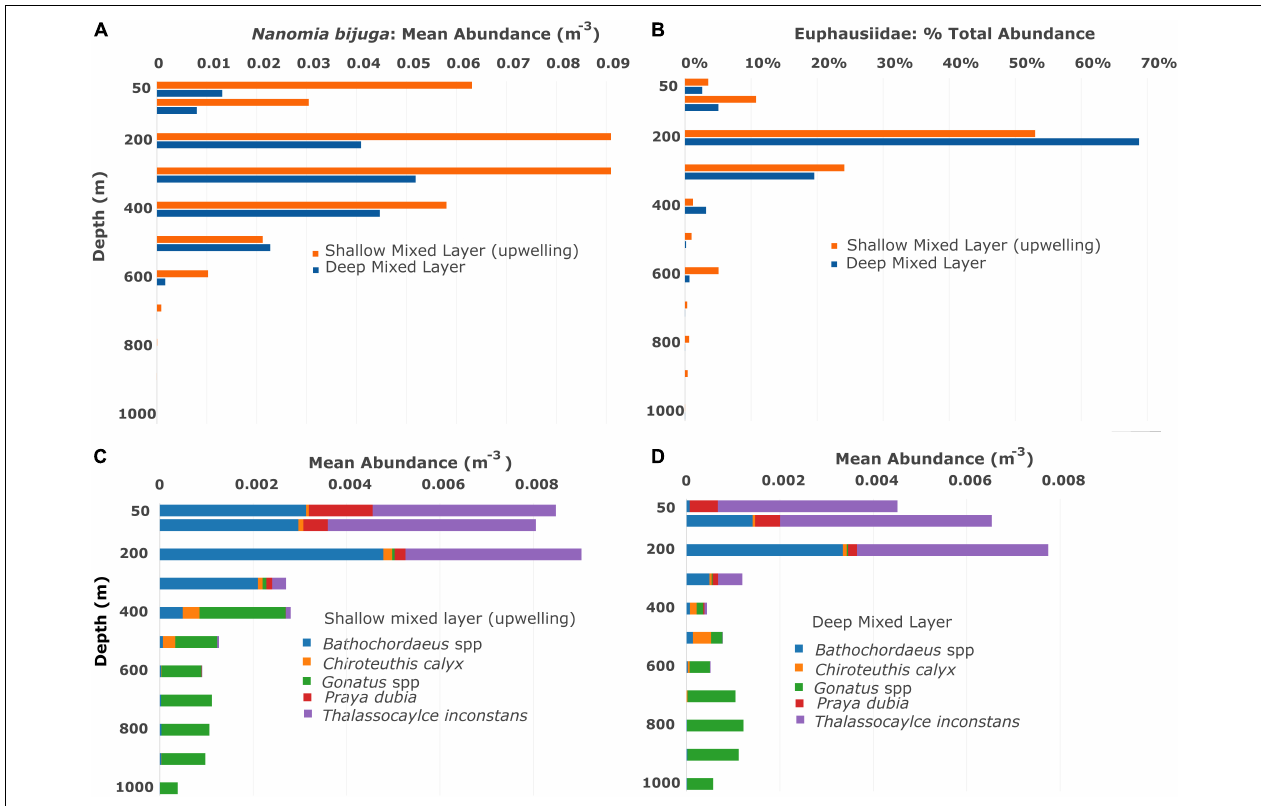
FIGURE 2 | Vertical and seasonal distributions based on the Midwater Time Series, from 1997–2015 for (A) the siphonophore Nanomia bijuga , (B) euphausiid krill, (C,D) giant larvaceans Bathochordaeus spp., the squids Chiroteuthis calyx and Gonatus spp., the siphonophore Praya dubia and the lobate ctenophore Thalassocalyce inconstans . The mixed layer of nutrients is shallow when upwelling is occurring and deeper when it is not, thus seasonality in Monterey Bay is broadly defined here by mixed layer depth. Mean abundances indicate that many mesopelagic animals are more abundant when the mixed layer is shallow and upwelling is occurring. Note that krill are expressed in percent abundance because quantifying each euphausiid on video is not always